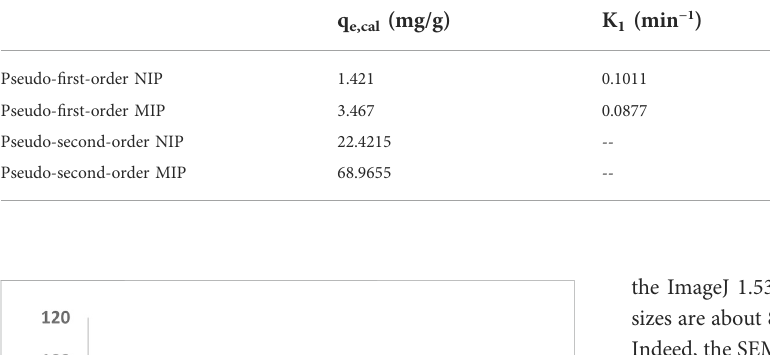
TABLE 2 Kinetic parameters for pseudo- fi rst-order equation and pseudo-second-order equation at 25 ° C.